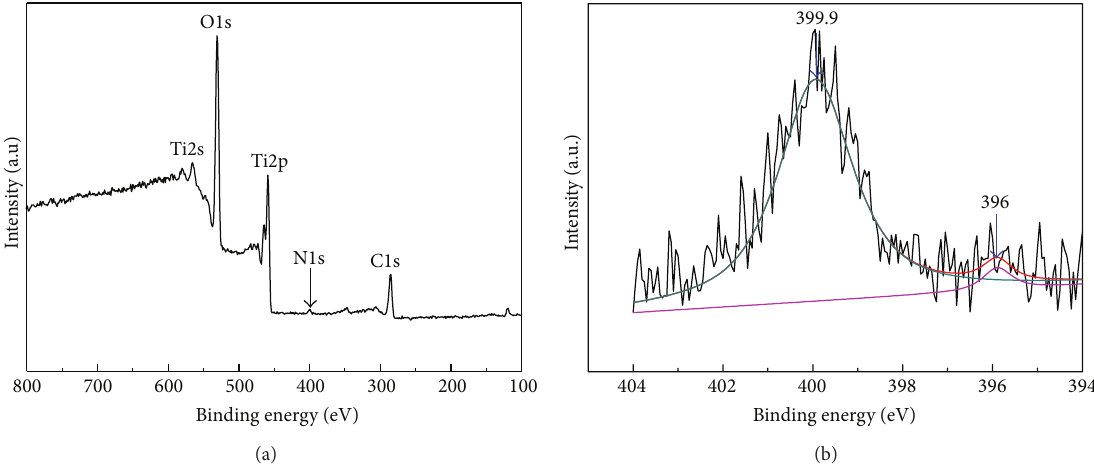
Figure 4: XPS survey spectra of (a) survey spectrum and (b) N1s.